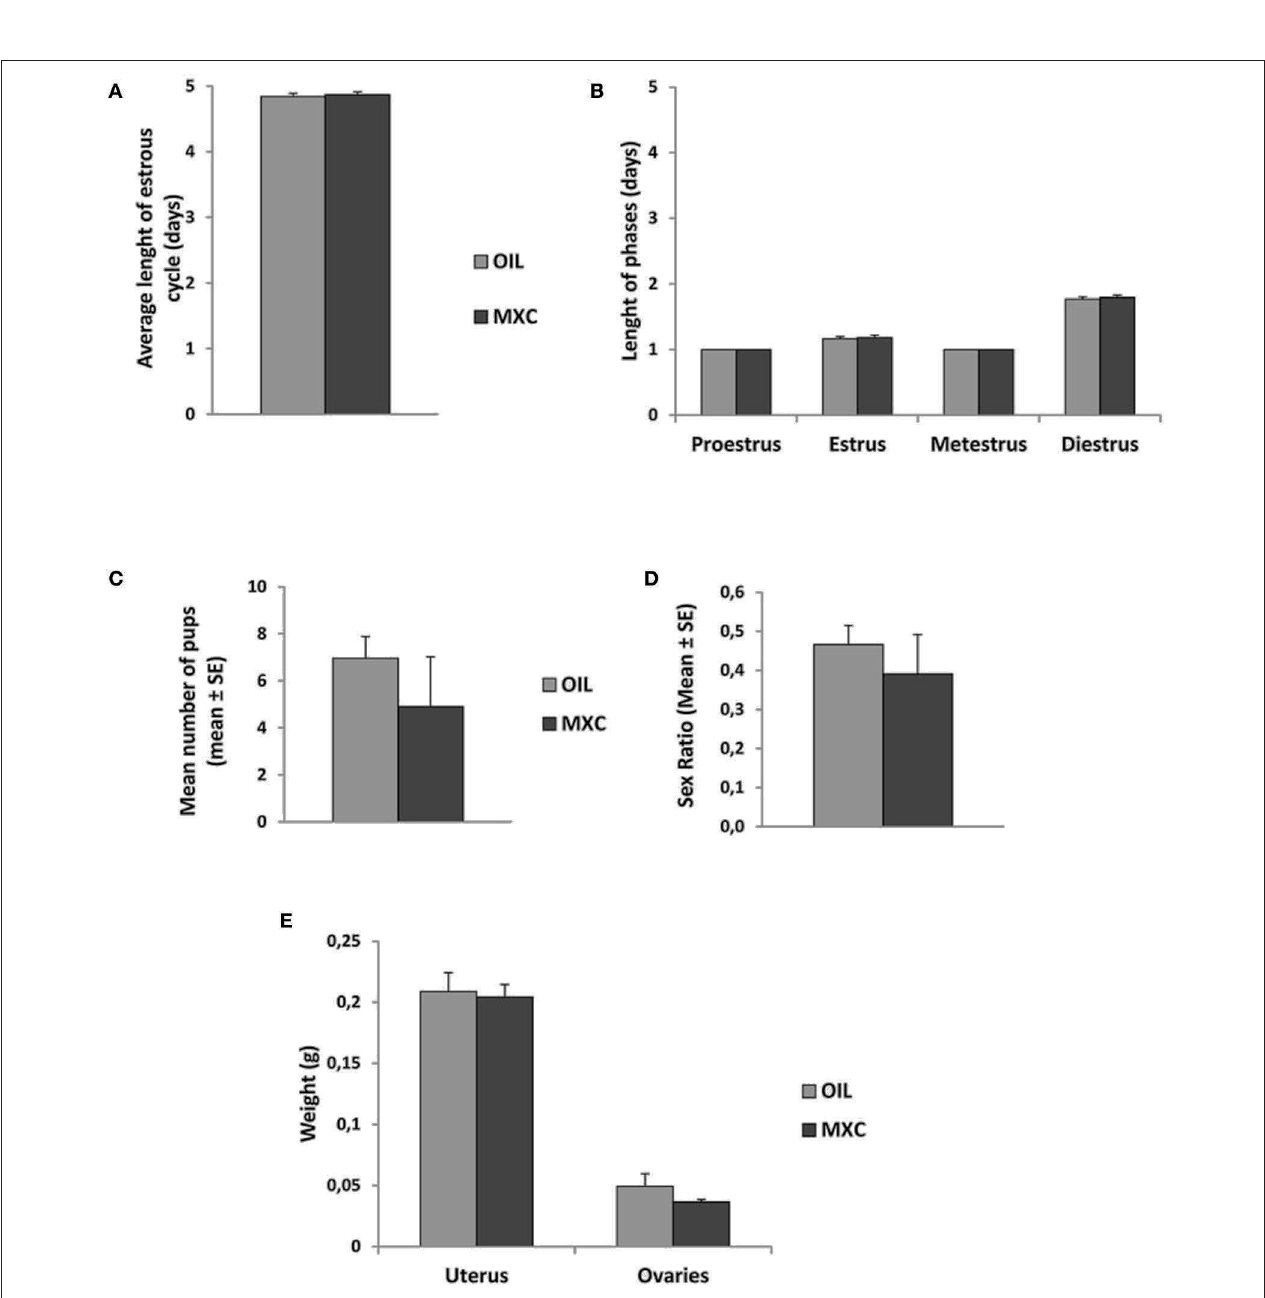
FIGURE 2 | Effect of perinatal exposure to MXC on female reproductive parameters. MXC exposure did not induce any effect in comparison to control females in average length of estrous cycle [both general length (A) and length of each phase (B) of the estrous cycle]. When paired with a sexually active male over a 3-months period, MXC treated females did not produce a different number of pups than control females and the sex ratio of these pups did also not vary (C,D) . Finally, no difference between uterus and ovaries weight was observed between MXC and OIL treated females (E) .